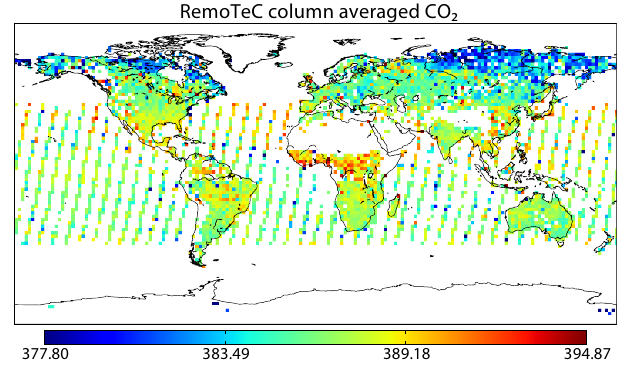
Fig. 2. X CO observed by GOSAT between 1 June 2009 and 1 Jan- 2 uary 2011, shown here averaged over a 2 ◦ × 2 ◦ grid. The averaging is only for visual clarity; the data assimilation considered each ob- servation individually. The color of a grid box represents the aver- age X CO within that grid box, in mole fraction of dry air expressed 2 as parts per